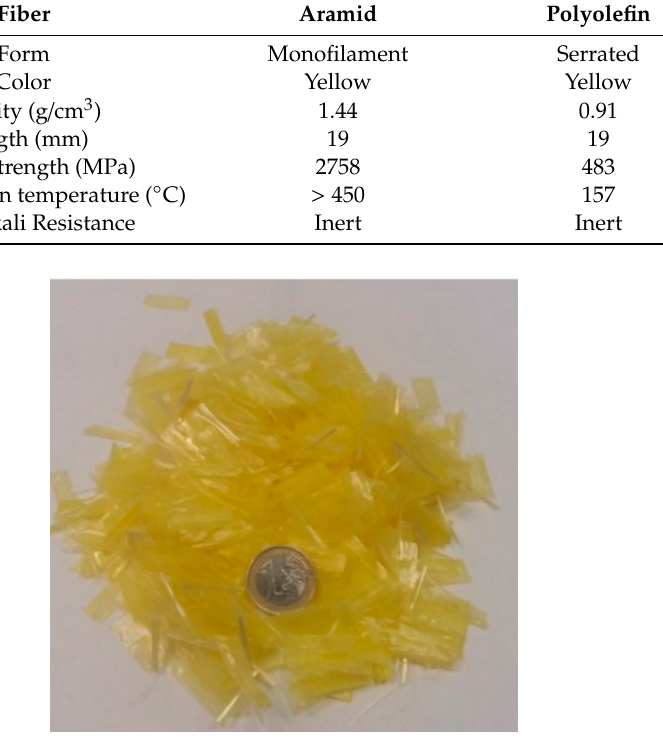
Figure 2. Blend of polyolefin and aramid (POA) fibers.